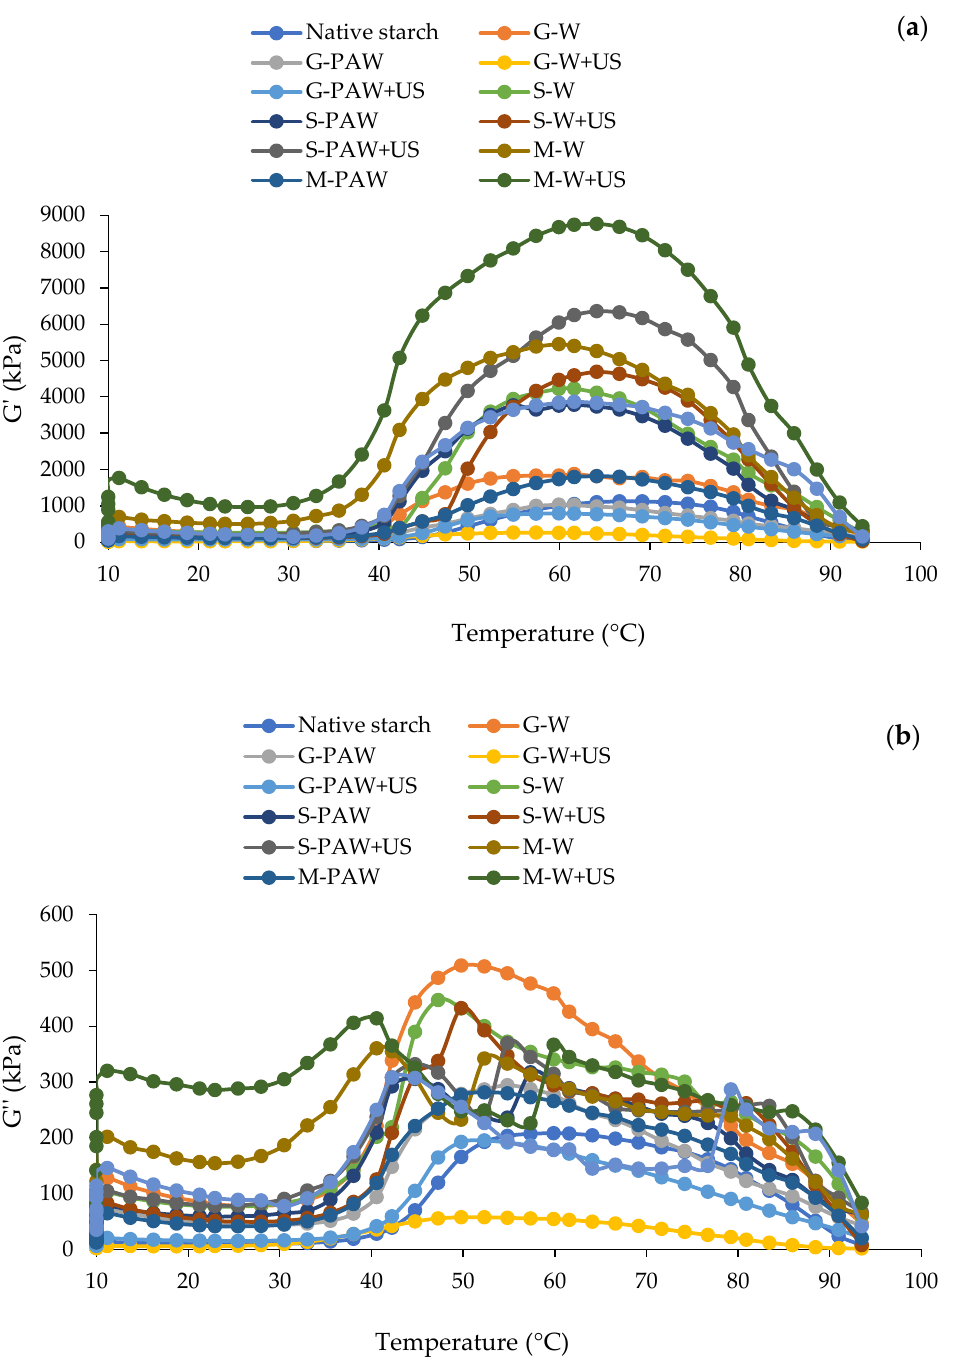
Figure 6. Storage modulus (G ′ ) ( a ) and loss modulus (G ″ ) ( b ) of rice starch – phenolic complexes. Different phenolic compounds — gallic acid (G), sinapic acid (S), and crude Mon-pu ( Glochidion wallichianum Muell Arg) extract (M) — were complexed with hydrothermally pre-gelatinized rice starch prepared using distilled water (W) or plasma-activated water (PAW) without and with the aid of ultrasonication (+US). The native starch was used to compare.